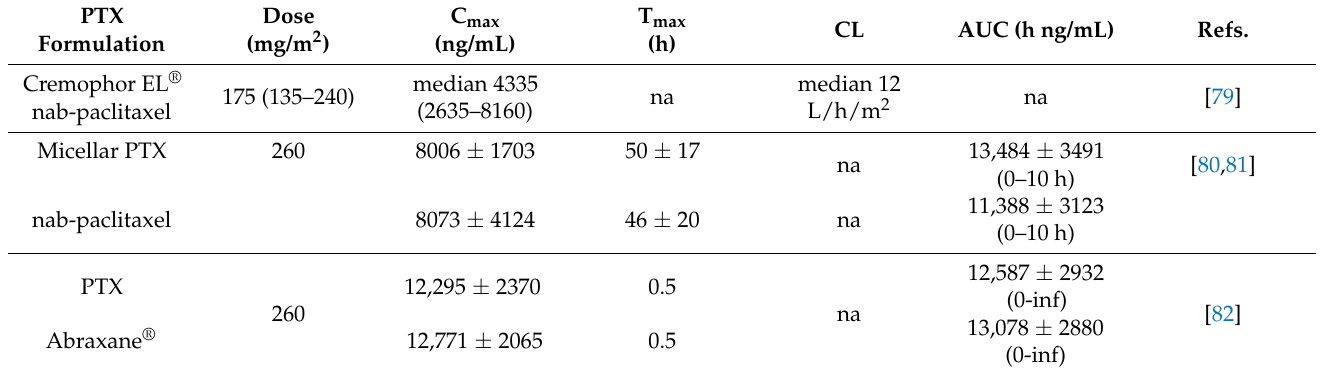
Table 3. Human pharmacokinetic parameters at different PTX